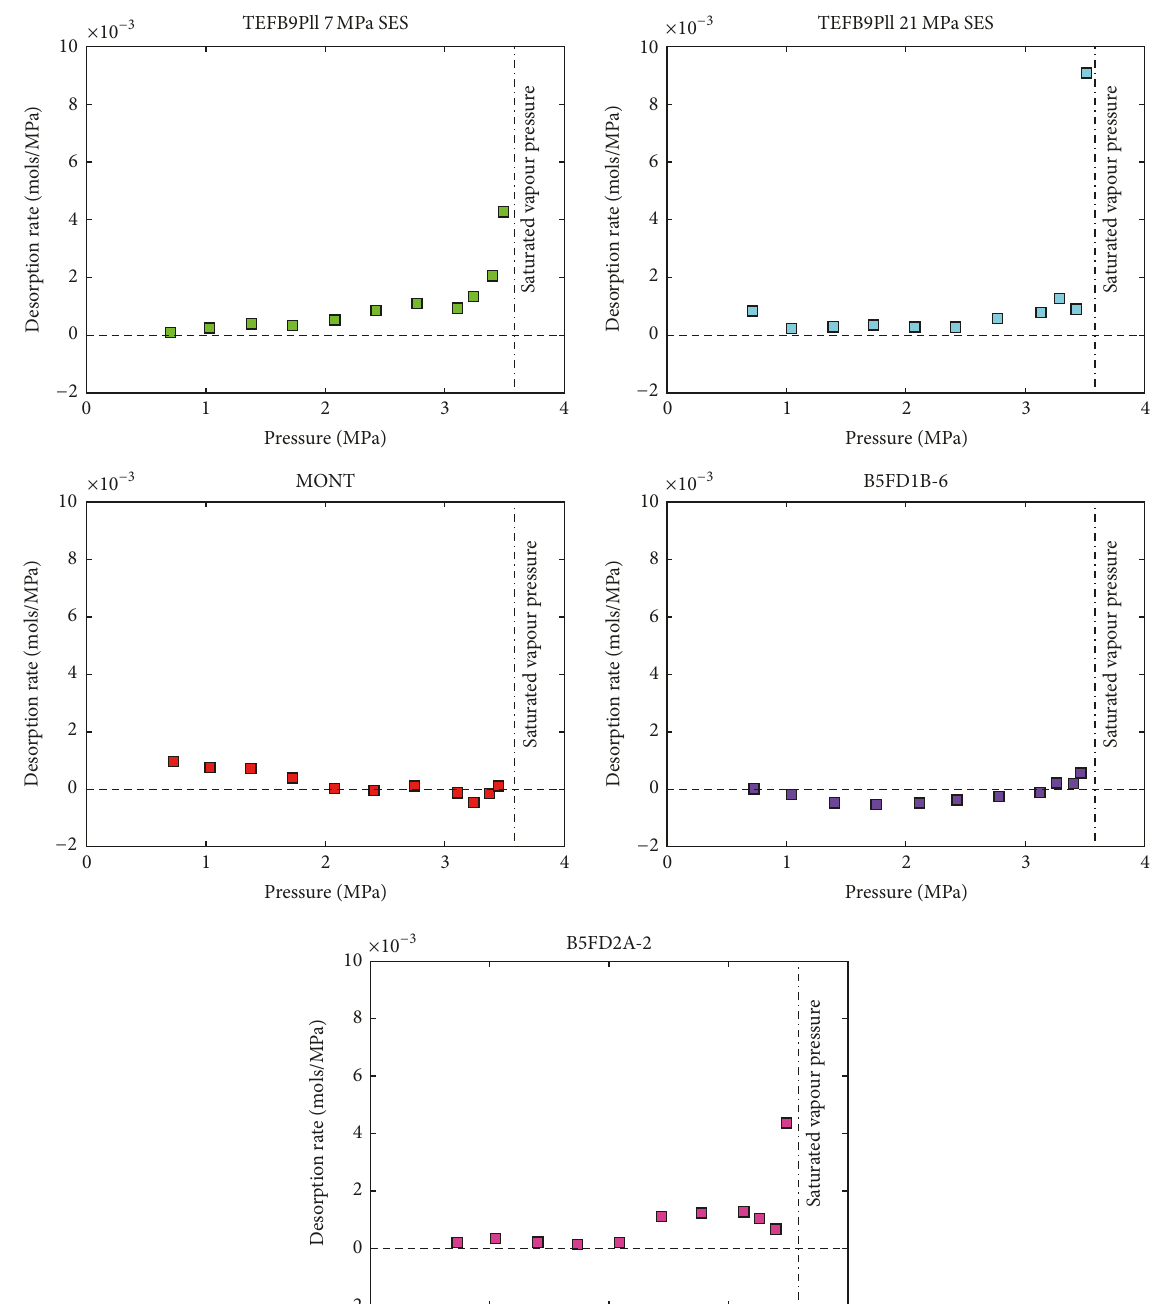
Figure 8: Ethane desorption rates calculated from the pulse decay pressure data. Desorption rate is elevated at high pressures for sample TEFB9Pll at 7 and 21MPa simple effective stress and sample B5FD2A2. Desorption rate is not elevated above resolution limit for samples MONT and